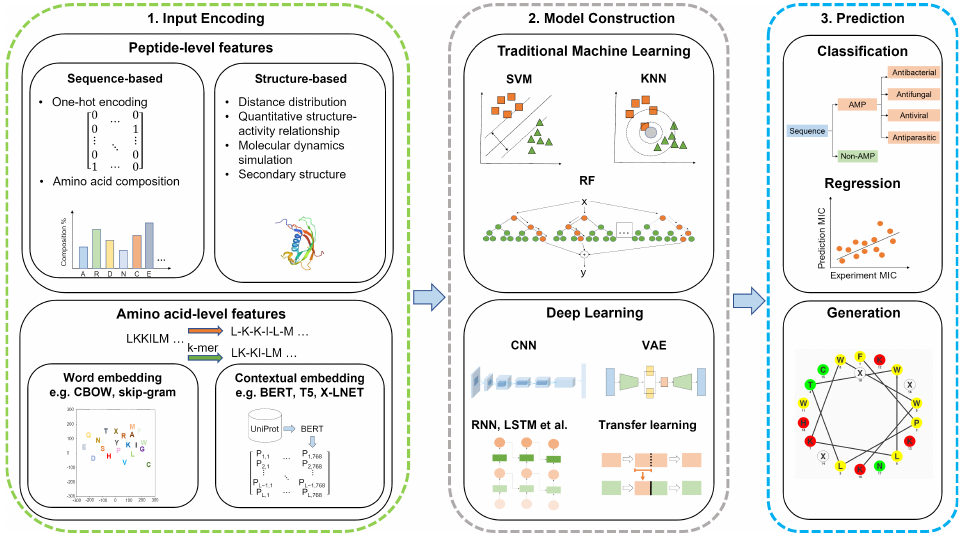
Figure 2. A general ML workflow of AMP discovery and design, including a summary of the major techniques in each stage of the